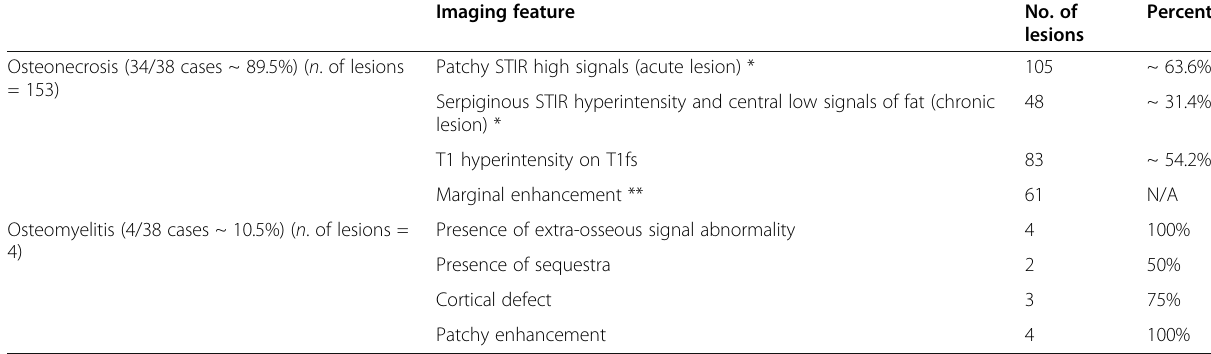
Table 4 Imaging features of focal signal abnormality marrow lesions (number of cases = 38/42, ~ 90.5%)